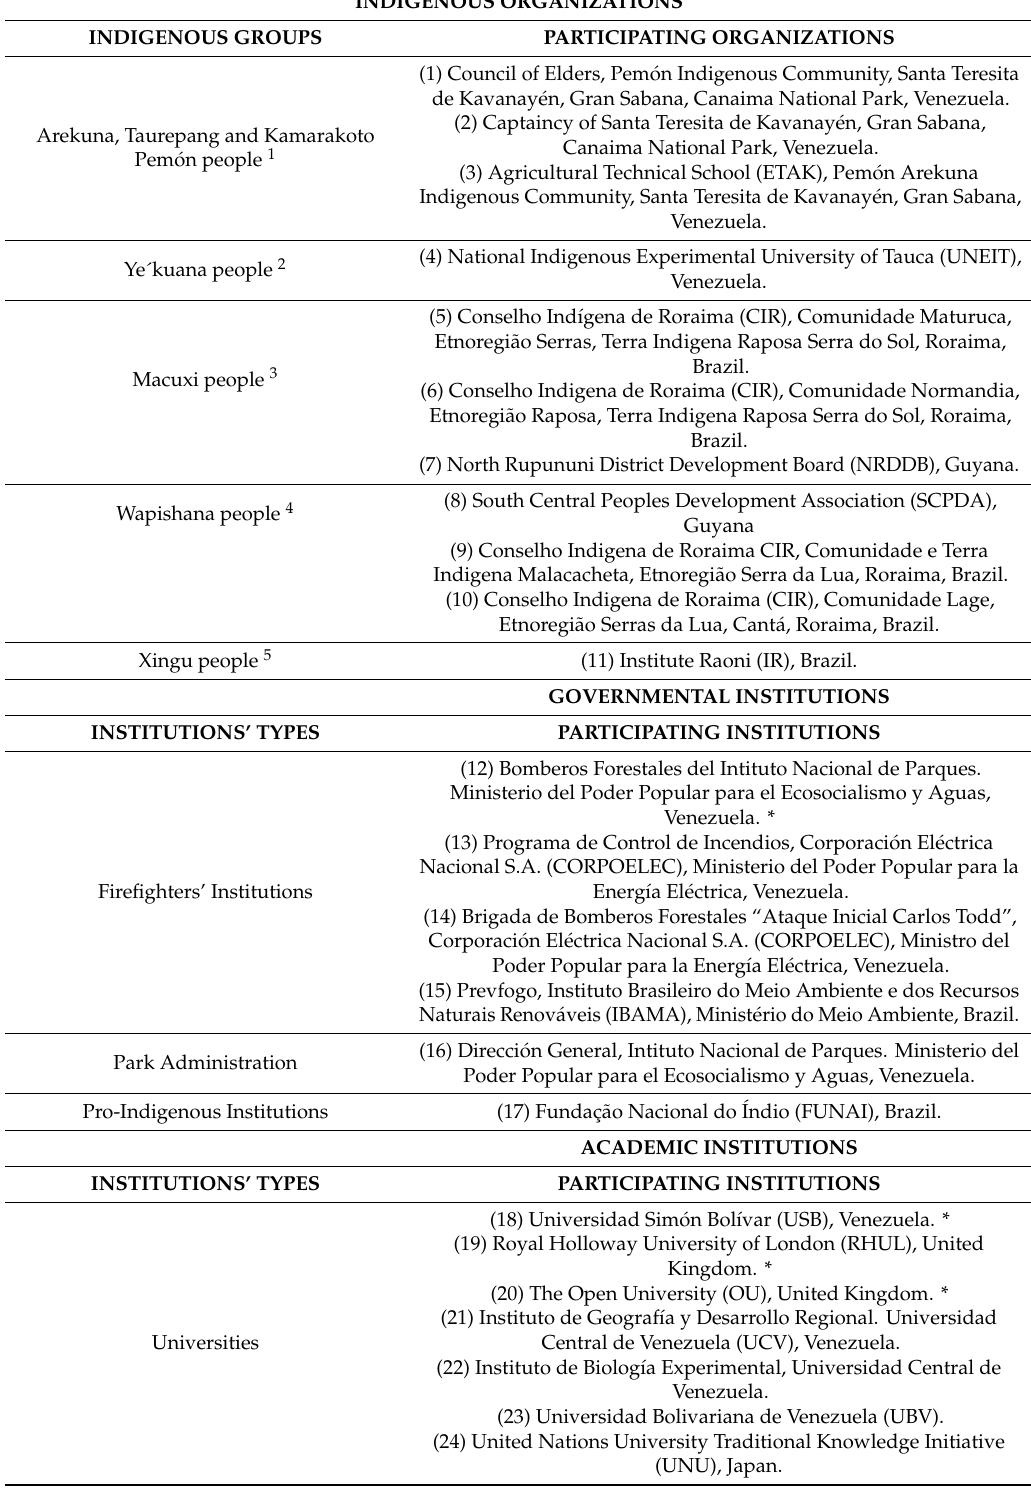
Table A1. List of participating organizations and institutions in the first workshop of Participatory and Intercultural Fire Management